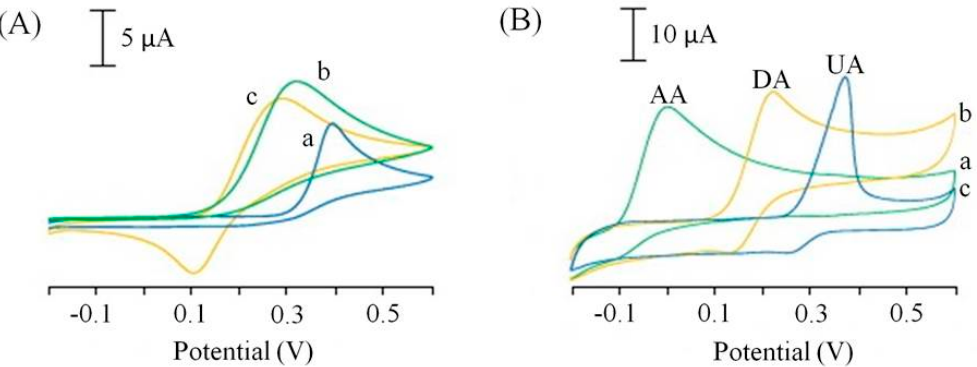
Figure 5. Cyclic voltammograms of 1.0 mM ascorbic acid (a), 1.0 mM dopamine (b), 1.0 mM uric acid at a screen printed electrode ( A ) and a screen-printed graphene electrode (SPGNE) ( B ). Supporting electrolyte: 0.1 M phosphate buffer saline (pH 7.0). Scan rate 50 mV/s. Adapted from [46].